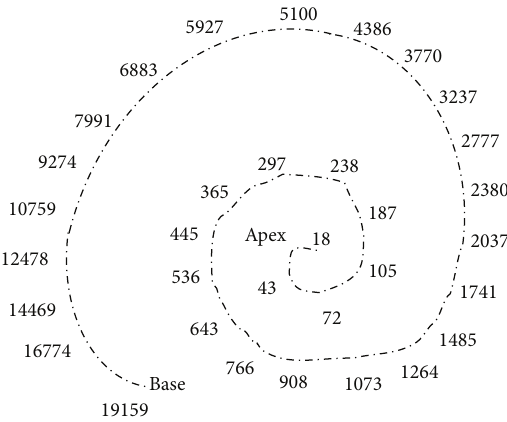
Figure 1: Cochlear implant structure.